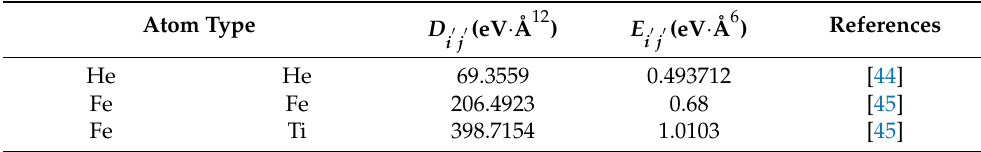
Table 3. Potential parameters for He-He, Fe-Fe, and Fe-Ti interactions with LJ (Lennard-Jones)